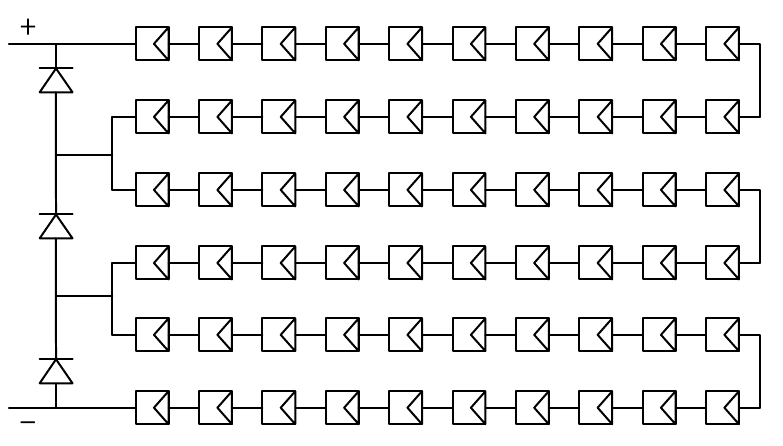
Figure 2. PV module internal circuit